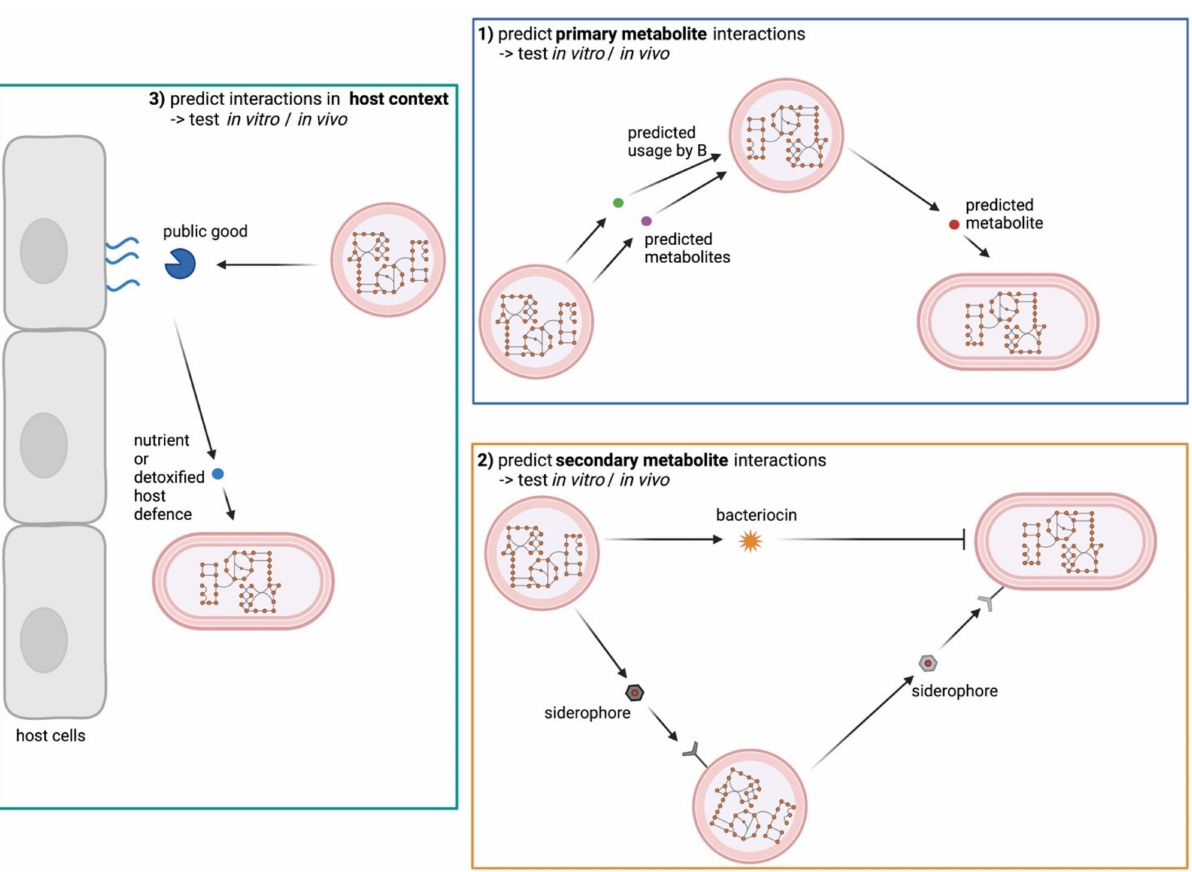
Figure 4. Metabolic models for prediction of bacterial interactions. Using metabolic models, primary metabolite interactions in bacterial communities can be modeled ( blue box ). Secondary metabolites such as siderophores and bacteriocins should also be regarded in predicting interactions ( orange box ) as well as public goods released from human host macromolecules ( green box ). This figure was created with